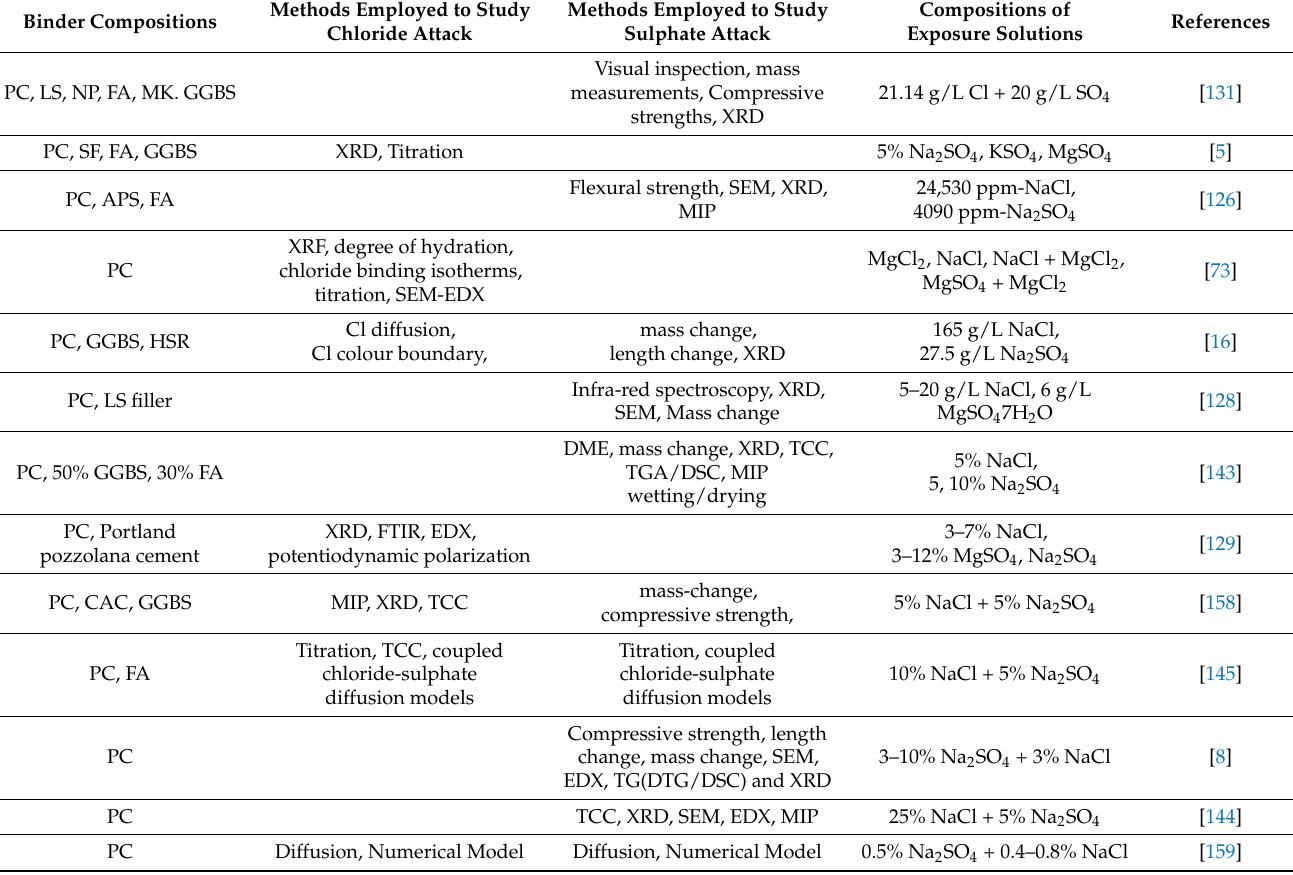
Table 5. Selected recent studies to highlight differences in binder compositions and